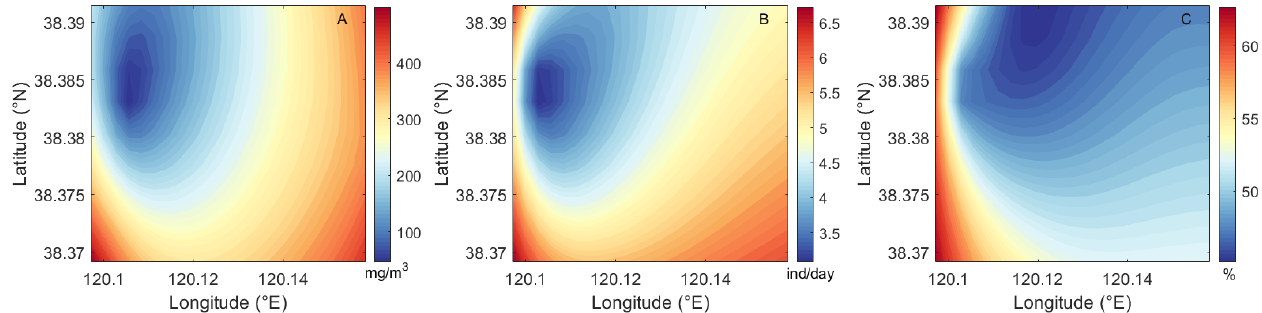
Figure 9. Distribution of the interpolated TPH concentration ( A ), death rate ( B ) and mortality ( C ) of Shellfish on 18 June.